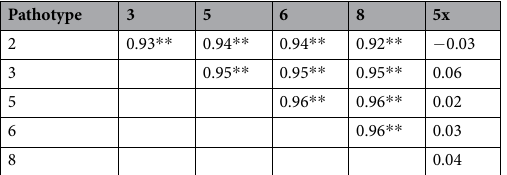
Table 1. Correlation coefficients among the disease severity index values after inoculation of BC 1 S 1 families derived from ACDC × T19 for resistance to six pathotypes of Plasmodiophora brassicae . ** Significance level at P < 0.01.